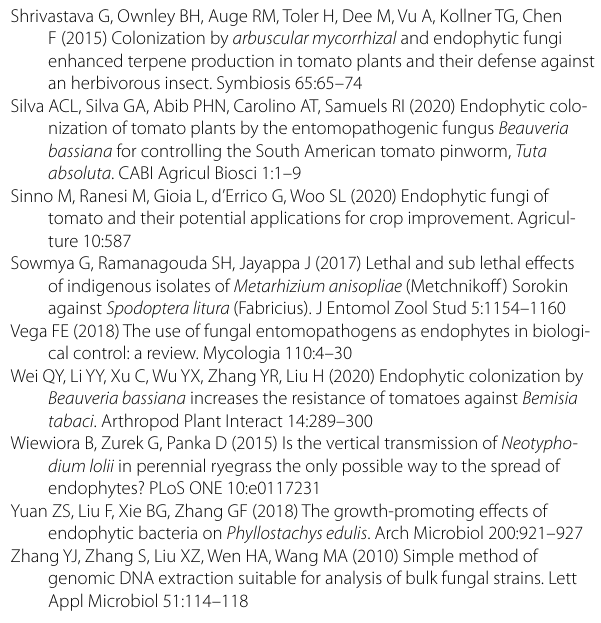
tabaci . Arthropod Plant Interact 14:289–300 Wiewiora B, Zurek G, Panka D (2015) Is the vertical transmission of Neotypho- dium lolii in perennial ryegrass the only possible way to the spread of endophytes? PLoS ONE 10:e0117231 Yuan ZS, Liu F, Xie BG, Zhang GF (2018) The growth-promoting effects of endophytic bacteria on Phyllostachys edulis . Arch Microbiol 200:921–927